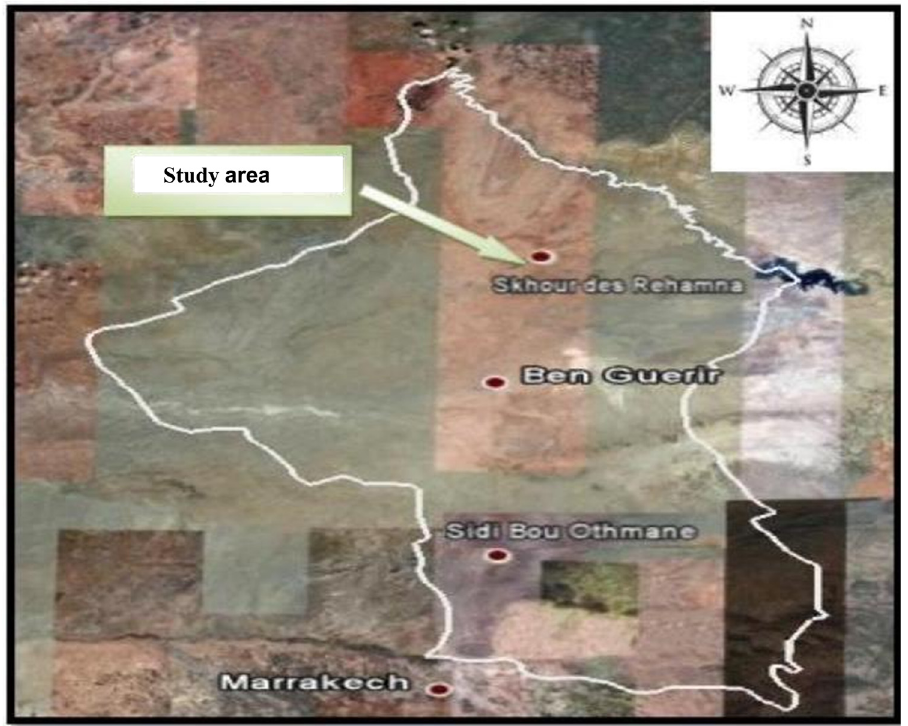
Figure 1: Geographical location of the study area ( Skhour Rhamna )